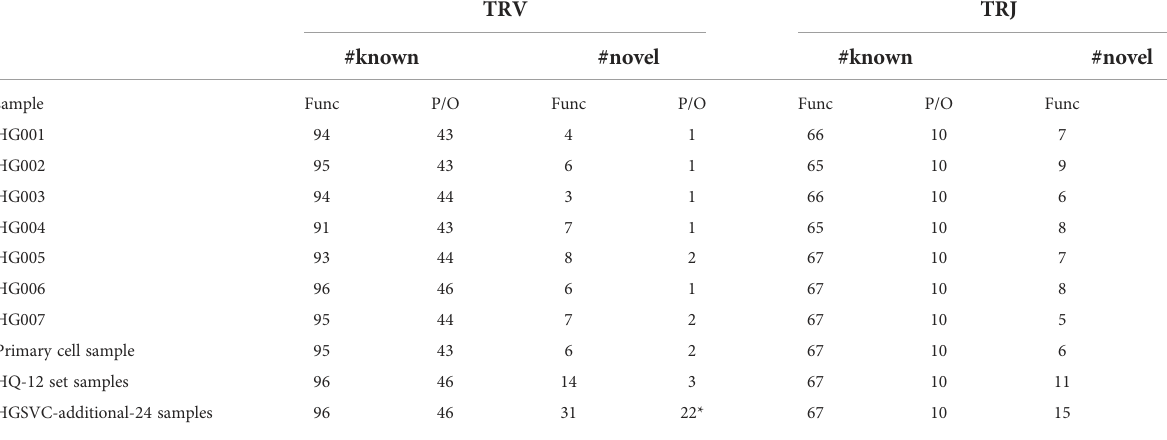
TABLE 1 Number of known and novel TR RSS in the gAIRR-called and gAIRR-annotated fl anking sequences.